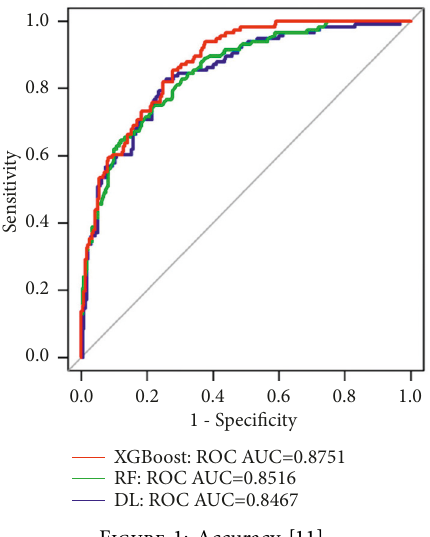
Figure 1: Accuracy